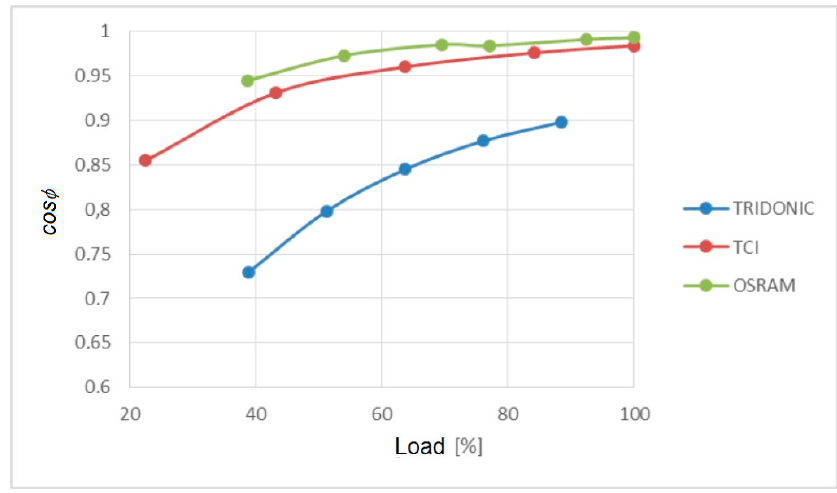
Figure 13. Impact of load increase on cos ϕ .